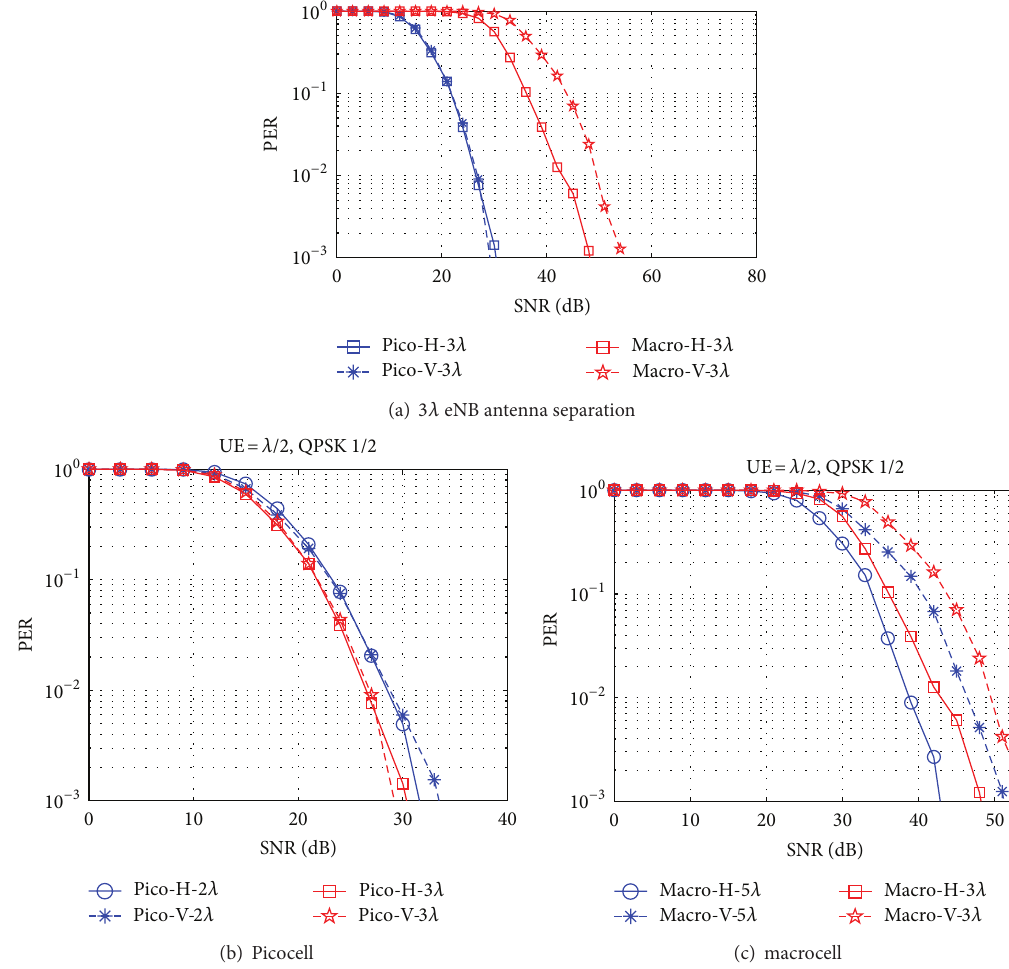
Figure 11: PER performance as a function of SNR for horizontal and vertical eNB antenna array configurations at different eNB antenna